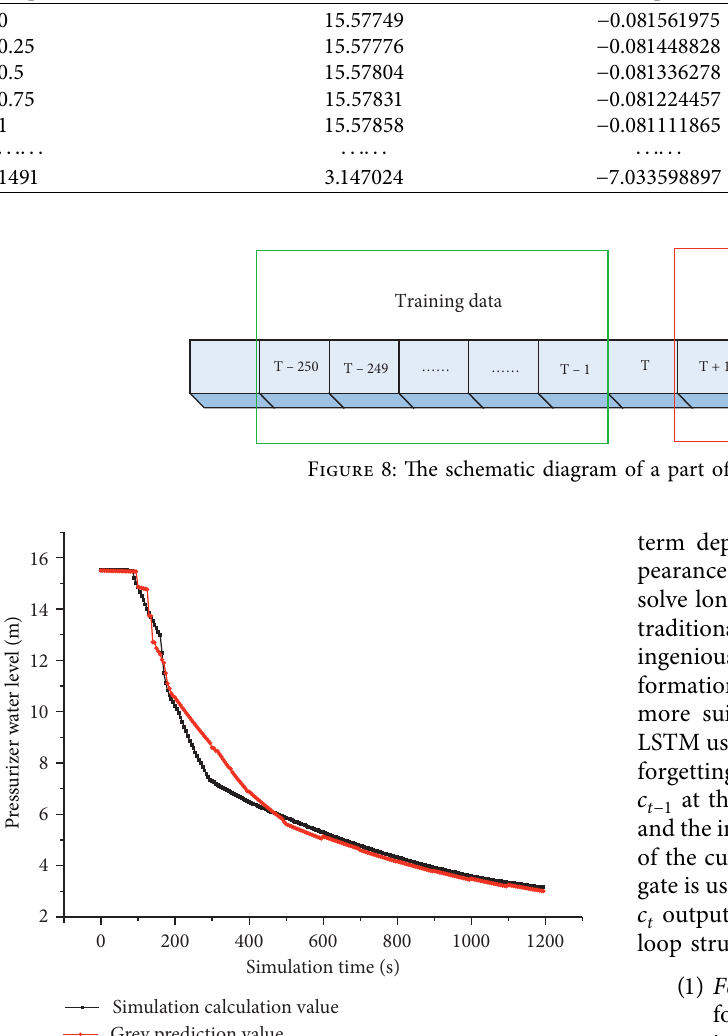
Figure 9: The comparison of the actual and predicted data of the pressurizer